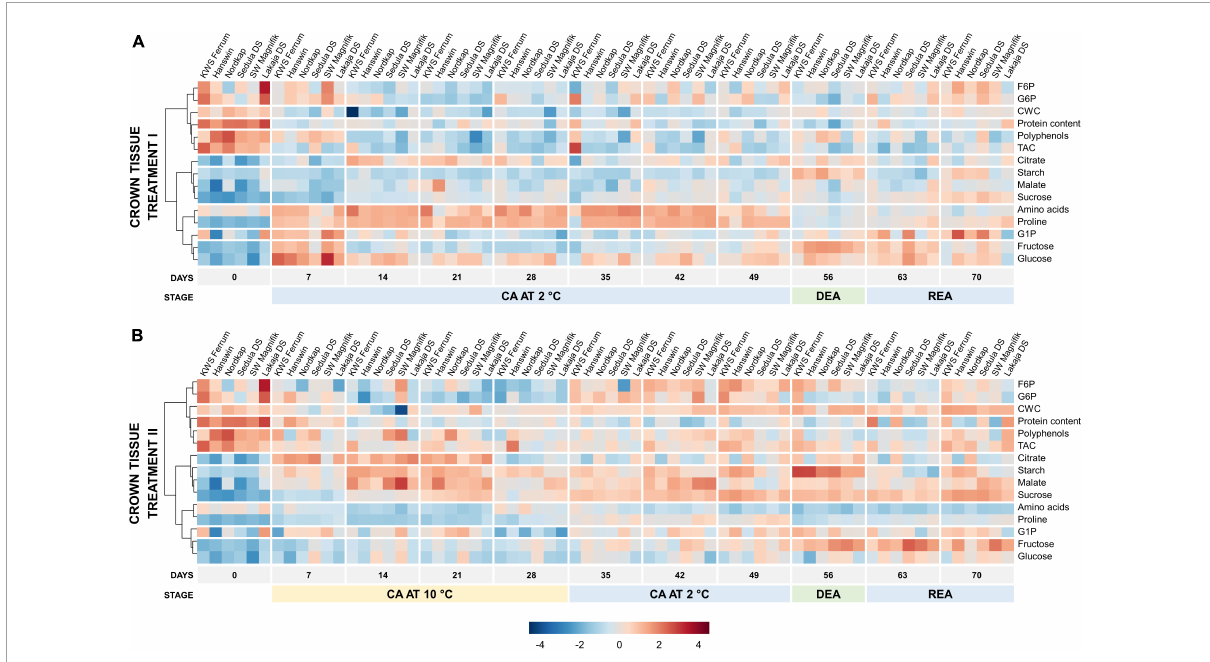
FIGURE5 Evolution of major biomass components and sugar-phosphates in the crowns of 6 winter wheat genotypes during two CA, DEA, and REA treatments. Heatmaps of metabolite concentrations in treatment I (A) and treatment II (B) . Each column represents the results of a single genotype on a given time-point. The genotypes are ordered by FT, from lowest to highest (“KWS Ferrum,” “Hanswin,” “Nordkap,” “Sedula DS,” “SW Magnifik,” “Lakaja DS,” respectively). Each row represents the scaled concentration of a given metabolite; a single cell signifies the average value of three biological replicates. Low values are marked as blue, and high values are marked as red. The data of both treatments I and II were treated and analyzed simultaneously and are